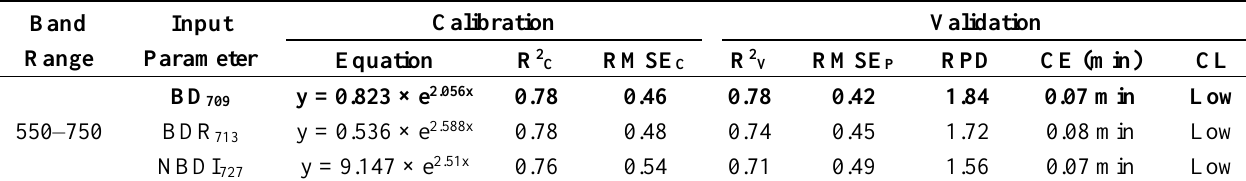
Figure 2. ( A ) The original spectrum, continuum line, and continuum-removed spectrum of Yumai 34 at the booting stage at an N rate of 150 kg/ha in Experiment 3. ( B ) Correlation coefficients between the band depth (BD), the band depth ratio (BDR), and the normalized band depth index (NBDI) and the LNC in the range of 550–750 nm. Table 3. The best-performing LNC models based on the continuum removal (CR) parameters for the calibration and validation sets.